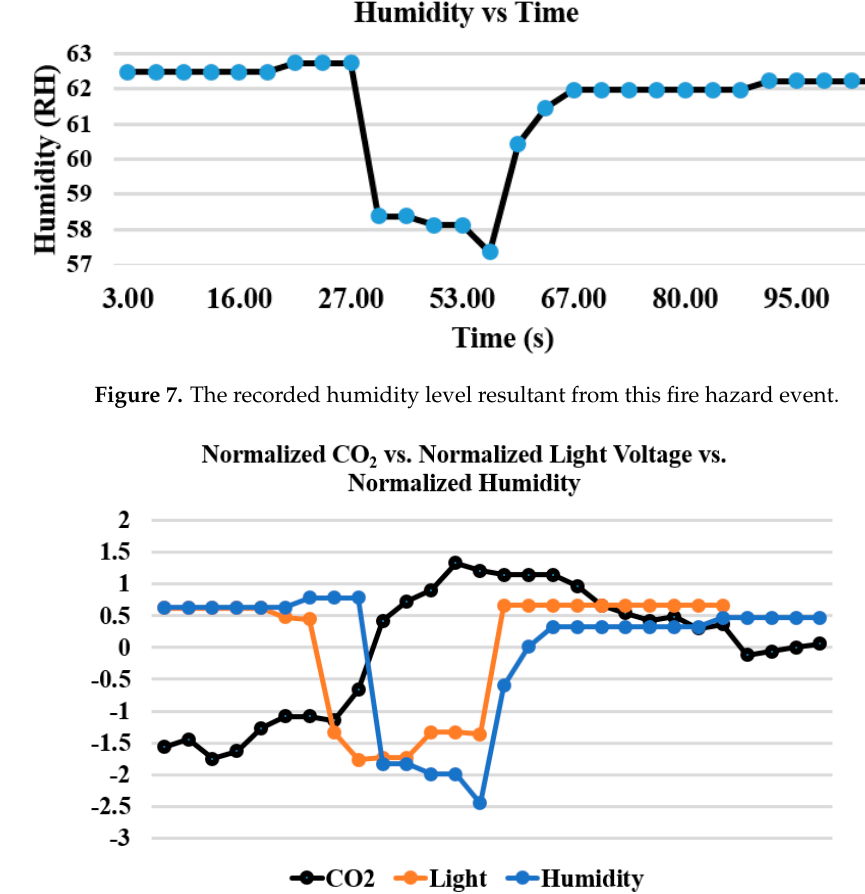
Figure 8. Comparison of the normalized sensor data from three heterogeneous sensors.